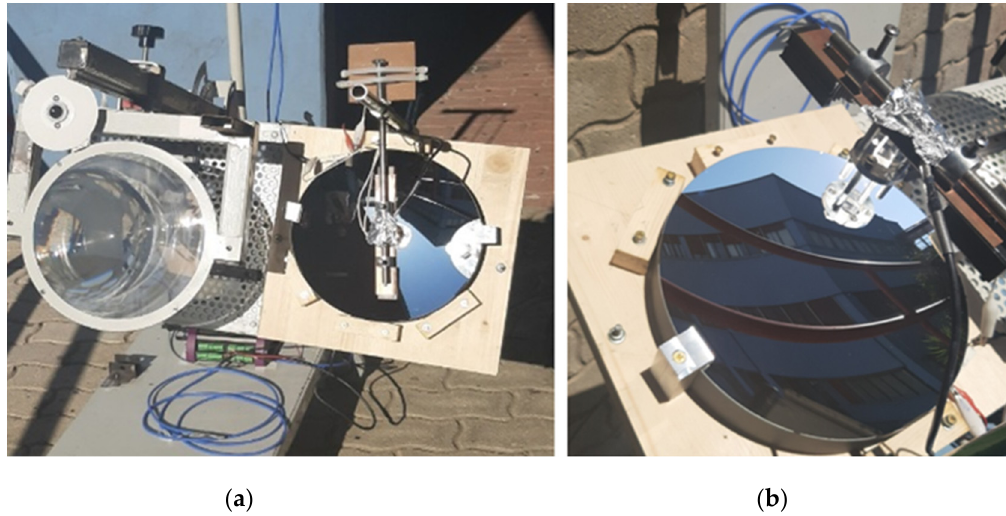
Figure 1. Photo of the experimental CPV system: CPV system with Fresnel lens and spherical mirror ( a ), detail of the spherical mirror ( b ).